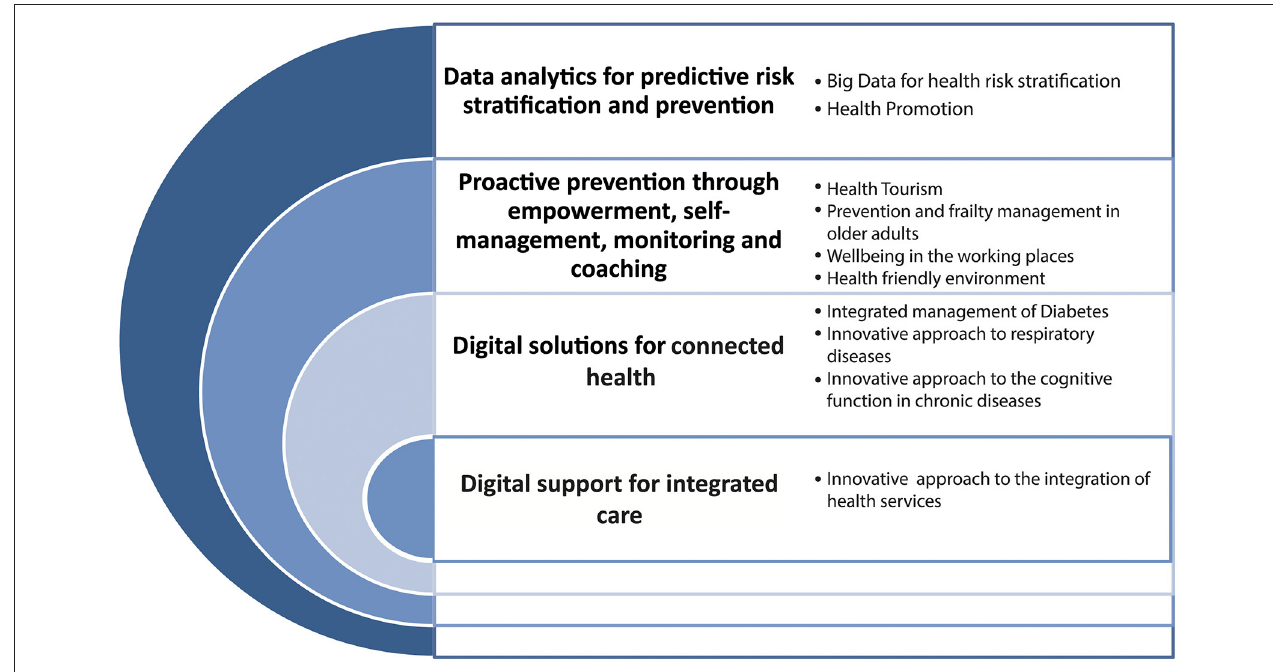
FIGURE 1 | Emerging directories of the health innovation ecosystem in Campania.